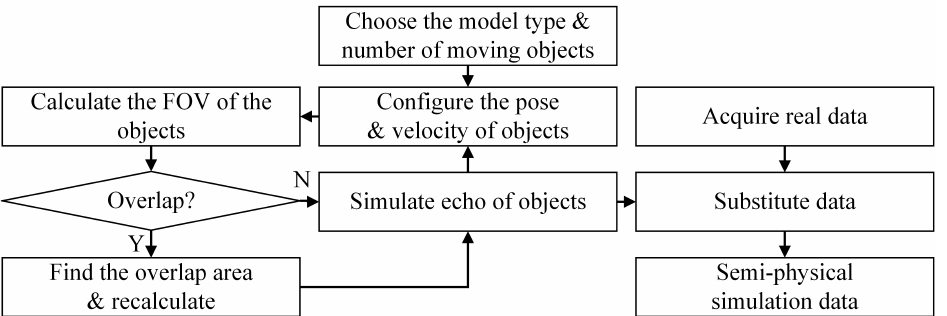
Figure 3. Generation of semi-physically simulated datasets. The real measurement data is partially substituted by the echo data from simulated moving